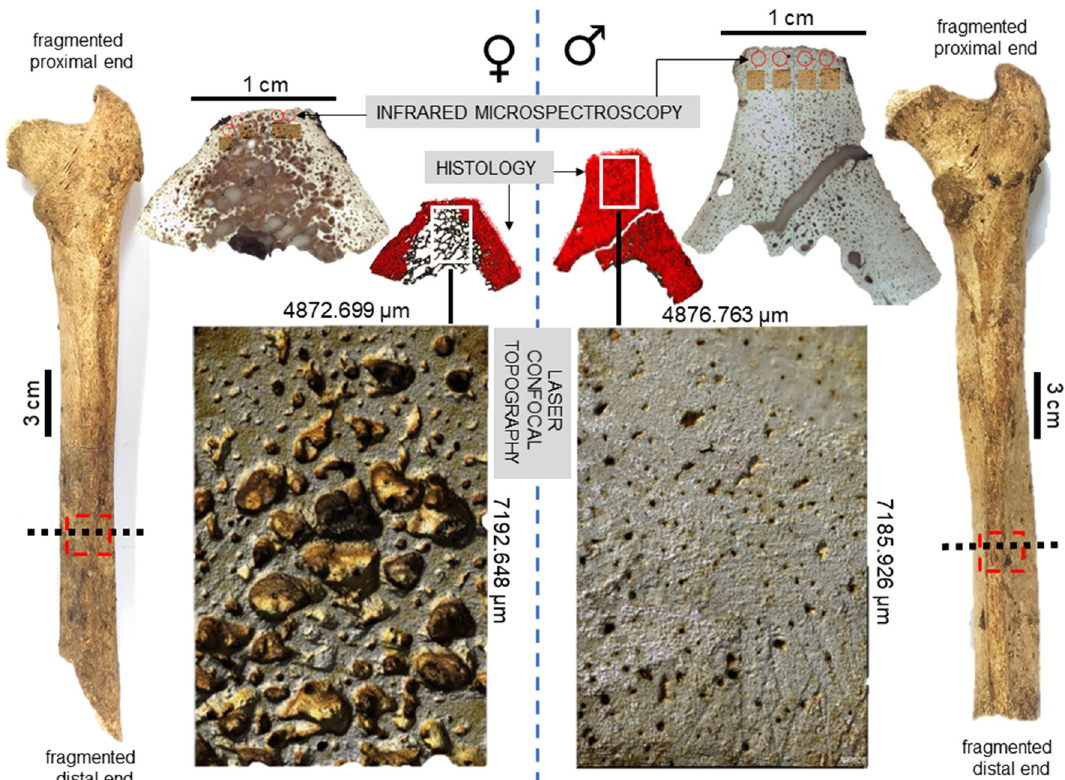
Figure 1. Summary of methods and key findings in the present study. Posterior view of two right archaeological femora from Talasiu individuals estimated as female ( ♀ , ID: Sk3.1) and male ( ♂ , ID: Sk3.2) shows the sectioning location (black dashed line) and approximate sample removed (red dashed box). Methodological steps included synchrotron sourced infrared microspectroscopy to measure bone mineral composition, histomorphometry to estimate Haversian canal densities (red dots), and laser confocal scanning of bone topography to provide a qualitative illustration of intra-cortical bone porosity producing